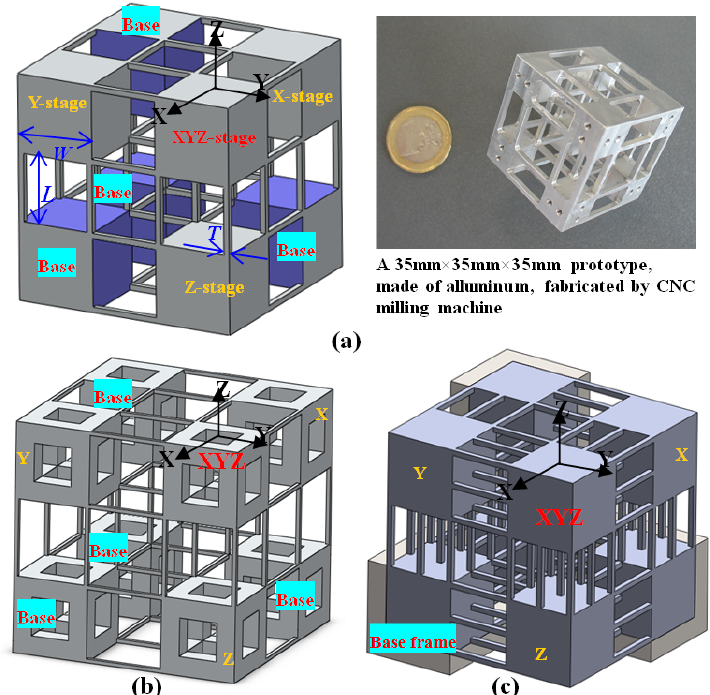
Figure 2. Monolithic decoupled XYZ CPMs: (a) a monolithic decoupled XYZ CPM with three geometrical parameters; (b) a monolithic decoupled XYZ CPM with improved natural frequency via reducing the cubic stage mass; and (c) a monolithic decoupled XYZ CPM with improved natural frequency via increasing the beam number (i.e. sti ff ness enhanced) (all configurations have same motion range).